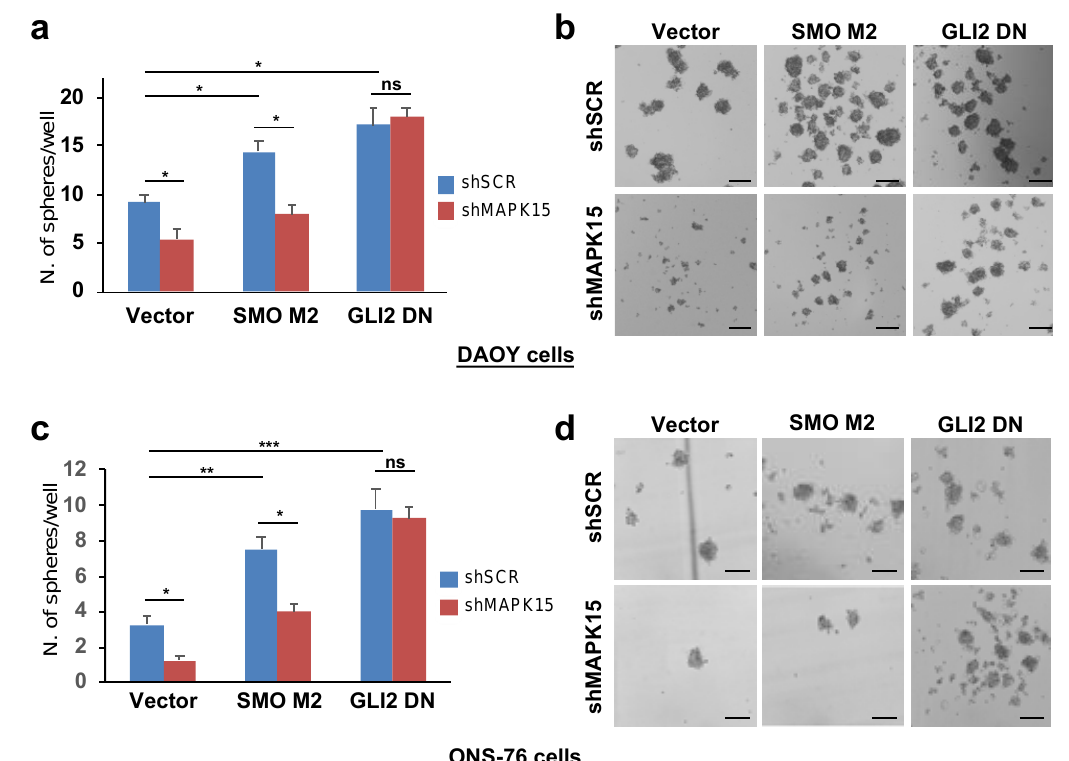
Figure 5. Overexpression of GLI2- ∆ N, but not of SMO-M2, rescues the decrease in medullo-sphere self-renewal upon MAPK15 silencing. Number ( a , c ) and representative images ( b , d ) of secondary spheres in DAOY ( a , b ) and ONS-76 ( c , d ) cells transduced with shSCR (blue bars) or shMAPK15 (red bars), and transduced with empty vector, SMO-M2, or GLI2- ∆ N. Scale bar = 150 µ m. *, p < 0.05; **, p < 0.01, ***, p < 0.001; ns, not significant.